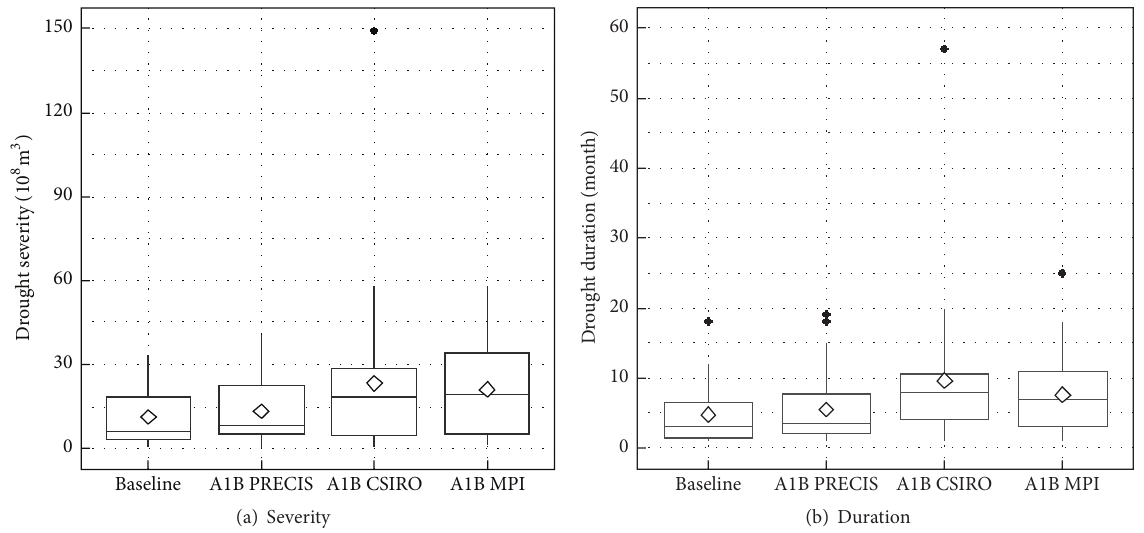
Figure 7: Boxplots for drought severity and duration samples under baseline and A1B scenarios (the diamond symbol indicates the means of drought severity or